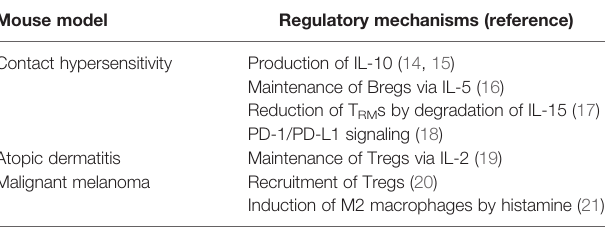
TABLE 1 | A summary of references regarding the regulatory functions of mast cells in the skin. Mouse